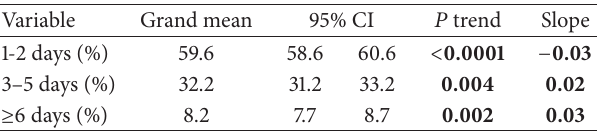
Figure 5: Caesarean section rate by year. Fraction of mothers giving birth in Maine who delivered by Caesarean section by year. The overall Caesarean section rate increased as a result of an increase in therateoffirst-timeCaesareansections.TherateofrepeatCaesarean sections remained unchanged. Healthy People 2020 has the objective of a 10% reduction in the rate of births by first-time Caesarean section. Maine is not moving toward this goal. Table 6: Length of hospital stay for infants born in Maine hospitals,